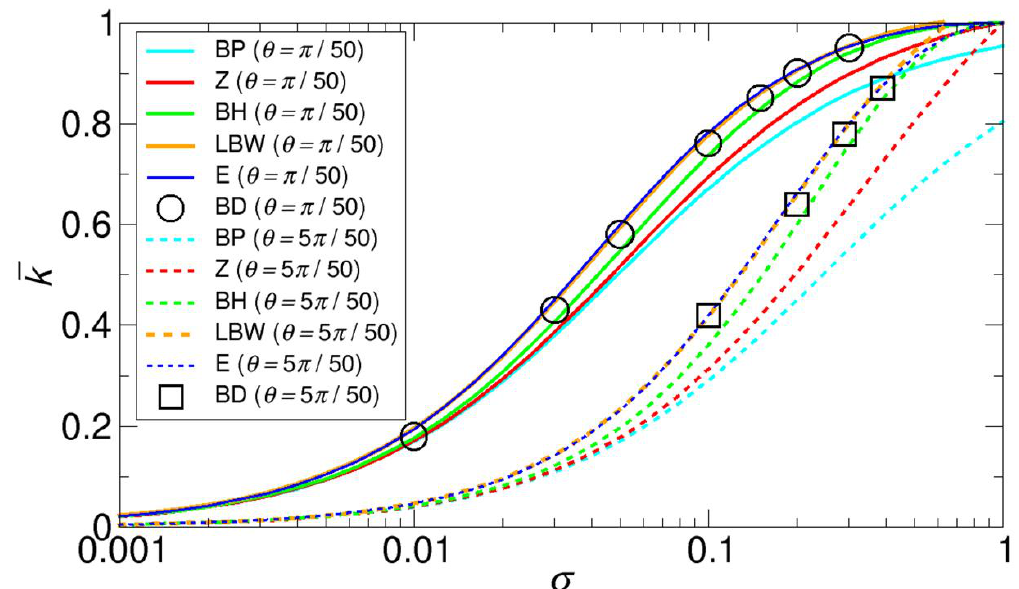
Figure 6. Comparison of the normalized rate constants k as functions of the total reactive area fraction σ , obtained from various methods with that from the BD simulations performed by Wu and Lu [30], with patch sizes of θ = 3.6 ◦ ( ) and 18 ◦ ( 5 ). Note that the x-axis is the logarithmic scale. The normalized rate constants for the Berg-Purcell (BP), the Zwanzig (Z), the boundary homogenization (BH), the Lindsay-Berno ff -Ward (LBW), and our (E) theory are calculated from Equations (1), (2), (3), (4), and (6), respectively. Note that the lines from the LBW and our theory are very close to each other.